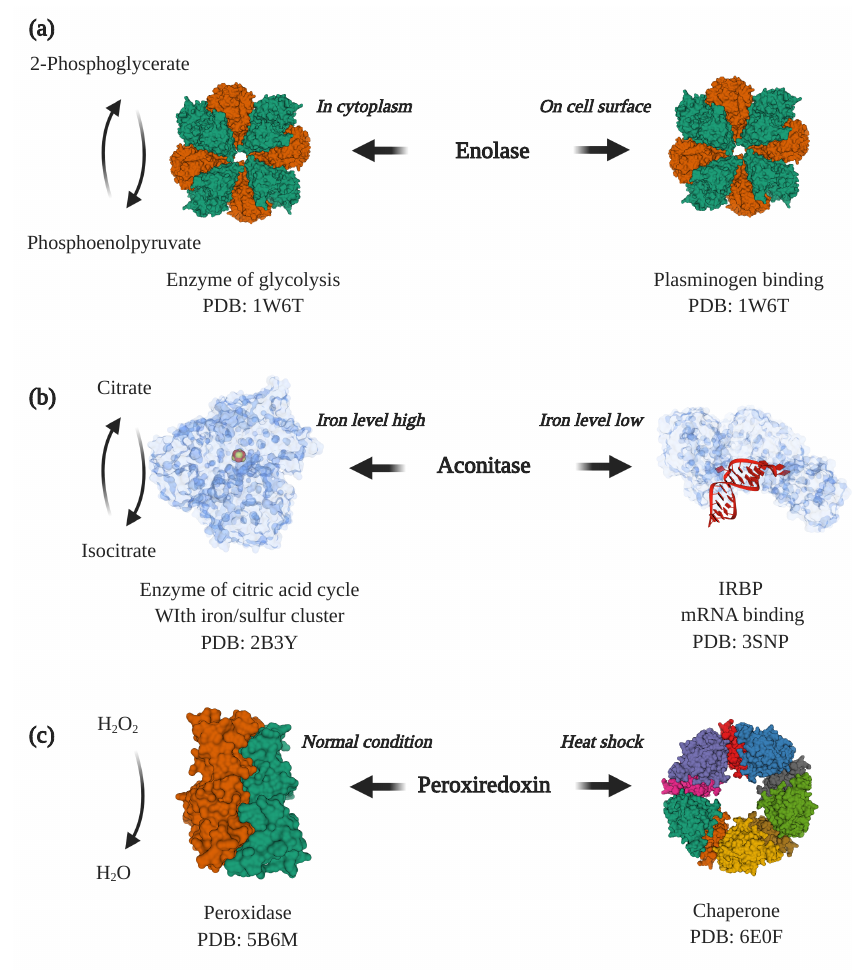
Figure 2. Examples of moonlighting proteins. ( a ) Enolase is a cytosolic enzyme in glycolysis and also a plasminogen receptor when displayed on the cell surface (PDB ID: 1W6T [31]). ( b ) Aconitase is an enzyme in the citric acid cycle when it contains an iron / sulfur cluster bound in the active site of the protein (PDB ID: 2B3Y [32]). When the cellular iron level decreases and the iron / sulfur cluster disassociates, aconitase undergoes a large conformational change that enables it to bind to iron-responsive elements in mRNA (PDB ID: 3SNP [33]) to promote the expression of proteins involved in iron uptake. ( c ) Under normal cellular conditions, peroxiredoxin is predominantly a dimer (PDB ID: 5B6M [34]) that functions as a peroxidase that converts hydrogen peroxide to water. Under heat shock or oxidative stress, it converts to a higher molecular weight form, a decamer, that acts as a molecular chaperone that assists with protein folding (PDB ID: 6E0F [35]). Note: This figure was “Created with BioRender.com”, and the visualizations of the protein structures were created with Mol* [36] on the RCSB PDB website (rcsb.org)